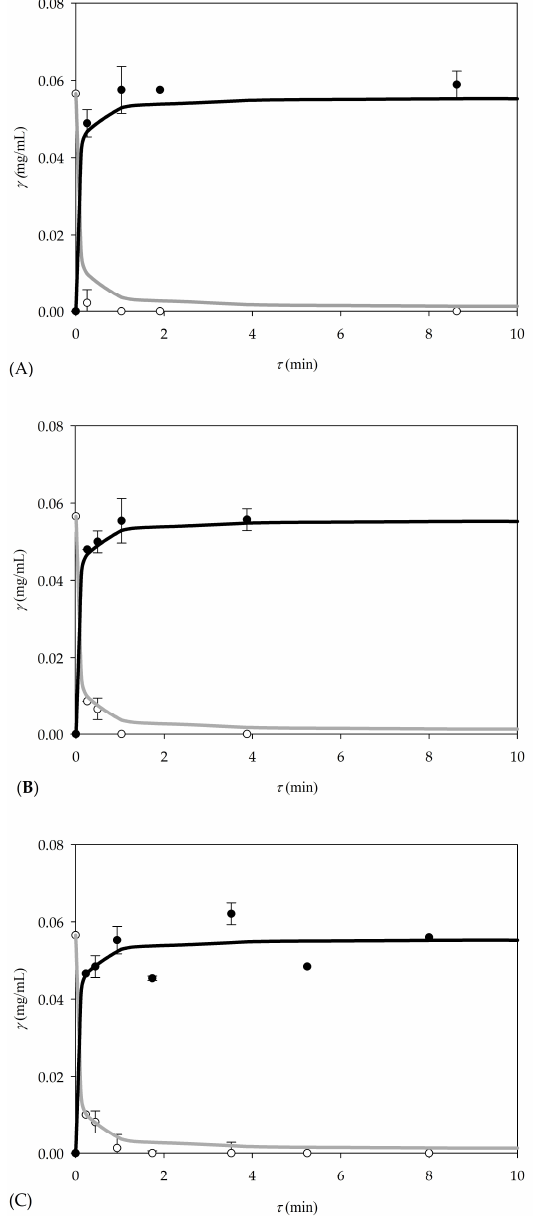
Figure 4. Effect of residence time on xylanase concentration in extract and raffinate phases for microextractors with two inlets and channel diameters of 500 μ m ( A ) and 1000 μ m ( B ) and for microextractors with three inlets and channel diameters of 1000 μ m ( C ) ( ● extract phase, ○ raffinate phase, ― mathematical model) .